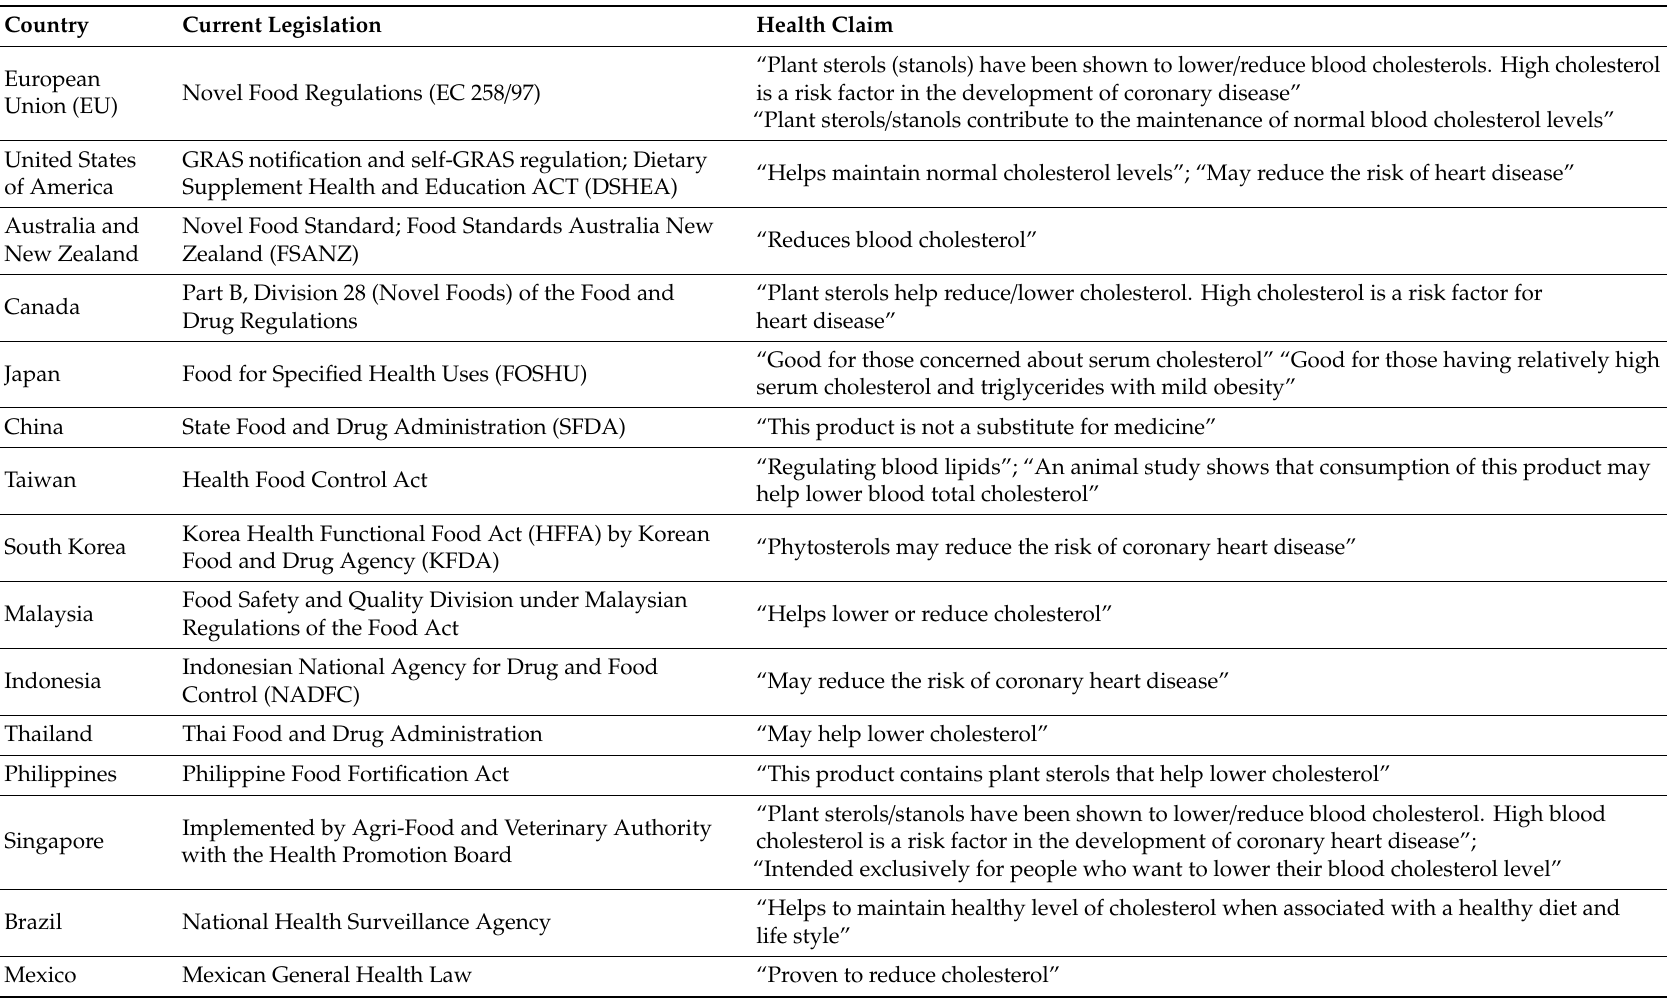
Table 3. Legislation on phytosterols-enriched foods in di ff erent